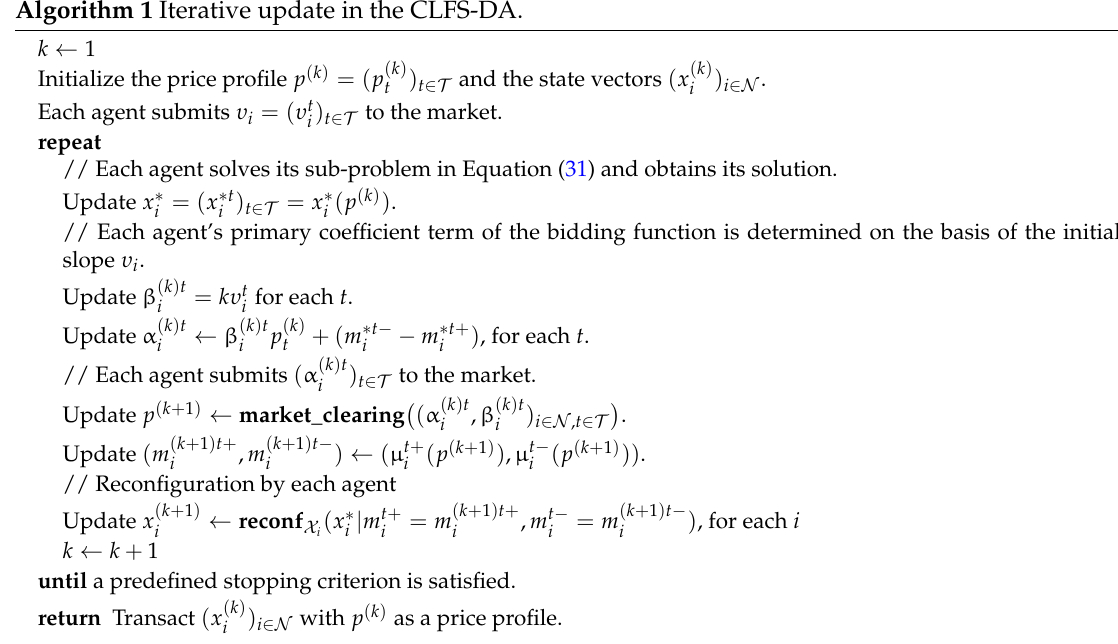
Algorithm 1 Iterative update in the